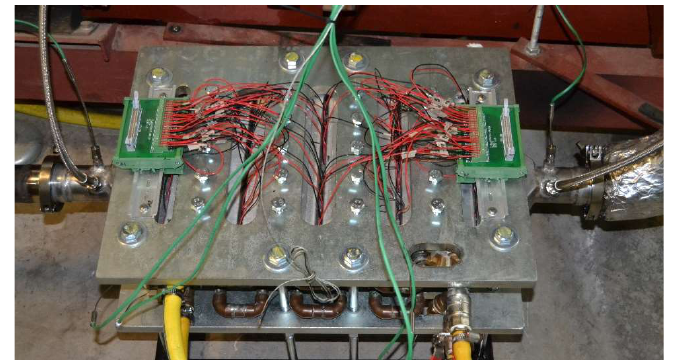
Figure 2. Prototype of the thermoelectric generator used for this study.